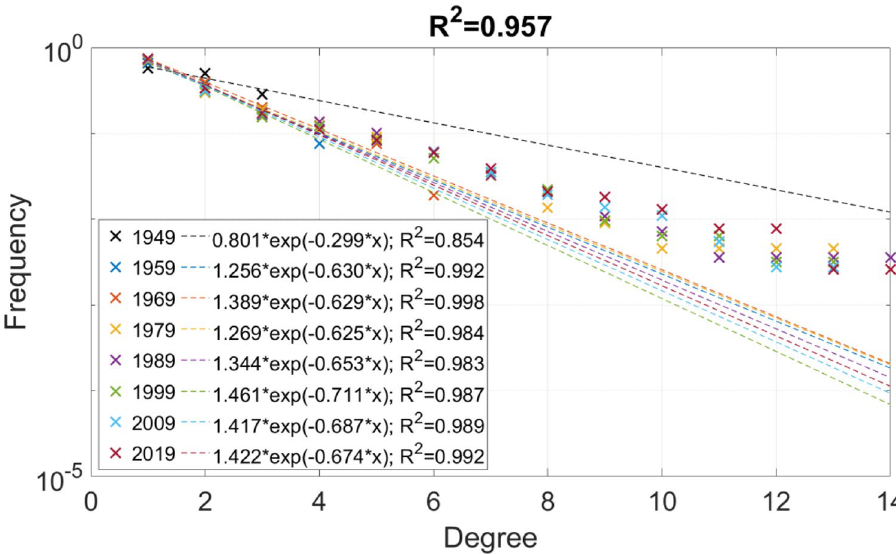
Figure 6. Cumulative node degree distribution and exponential fits.